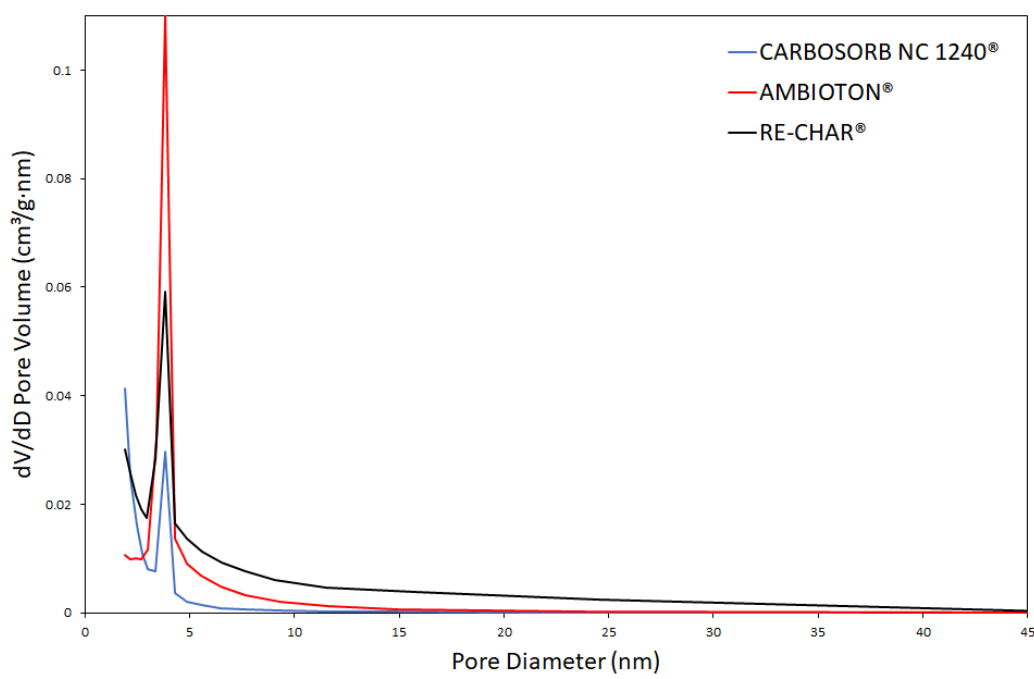
Figure 3. Pore size distribution of CARBOSORB NC 1240 ® , AMBIOTON ® , and RE-CHAR ® .